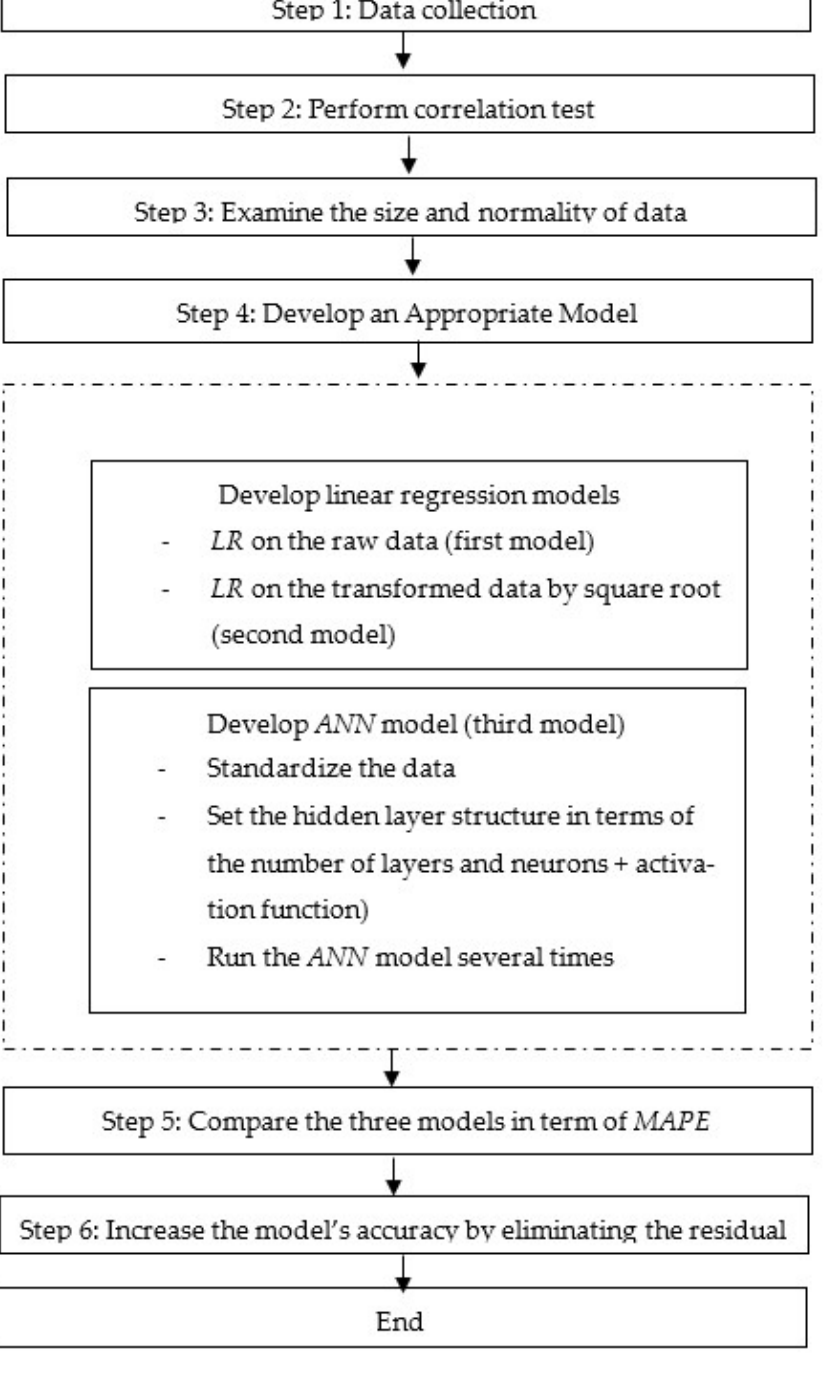
Figure 3. Flow chart methodology.